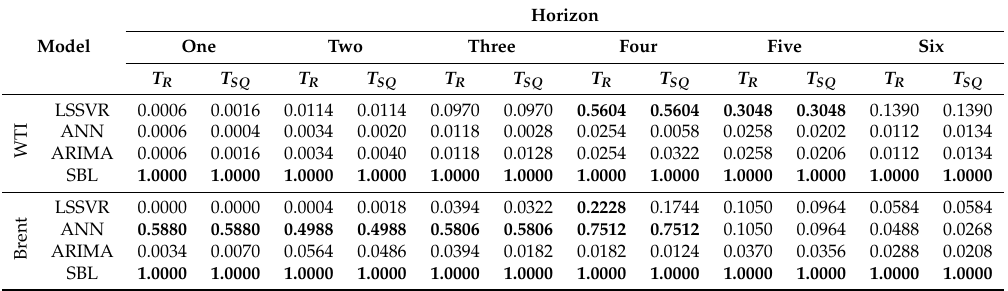
Table 6. The model confidence set (MCS) test results by different single models on WTI and Brent crude oil